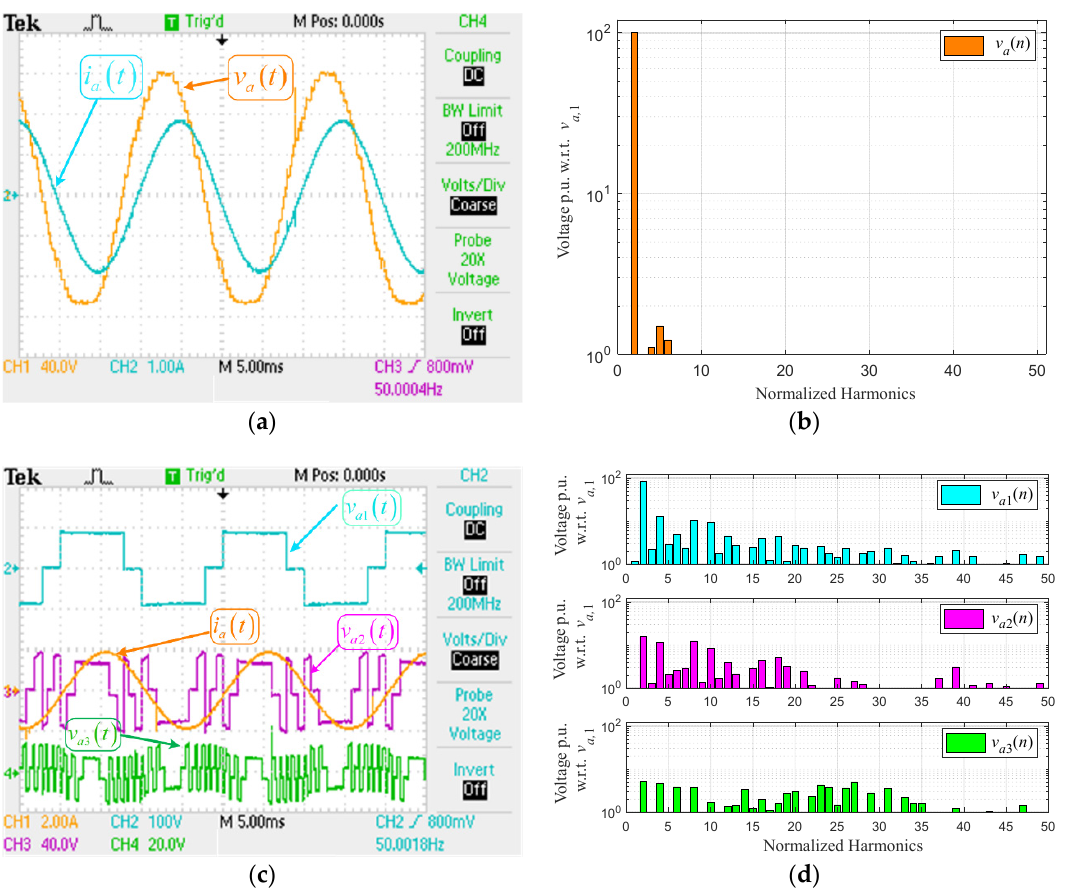
Figure 12. Experimental key waveforms for m = 1.0. ( a ) output voltage v a ( t ) and load current i a ( t ), ( b ) Harmonic spectrum for output voltage v a ( n ), ( c ) Individual inverter output voltages v ai ( t ) and load current i a ( t ), ( d ) Harmonic spectrum v a 1 ( n ), v a 2 ( n ), and v a 3 ( n ).